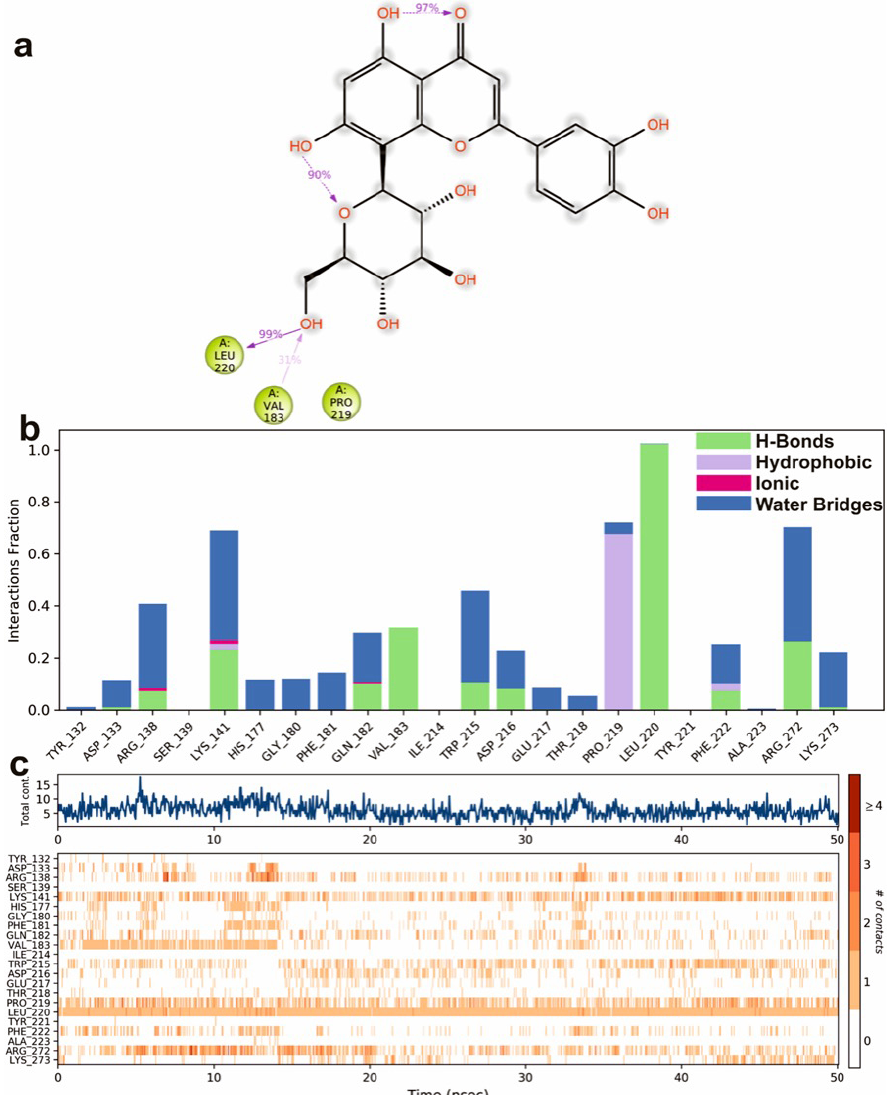
Figure 13. A scheme of detailed Orientin atom interactions with the protein residues. ( a ) Interactions that occur more than 30% of the simulation time in the selected trajectory. ( b ) Normalized stacked bar chart of compound Orientin interacting with NQO1 away from active site pocket through a hydrogen bond, hydrophobic and ionic interactions, and water bridges, and ( c ) The number of contact points with the amino acid residues are depicted in timeline representations coded with color intensity graphs throughout the